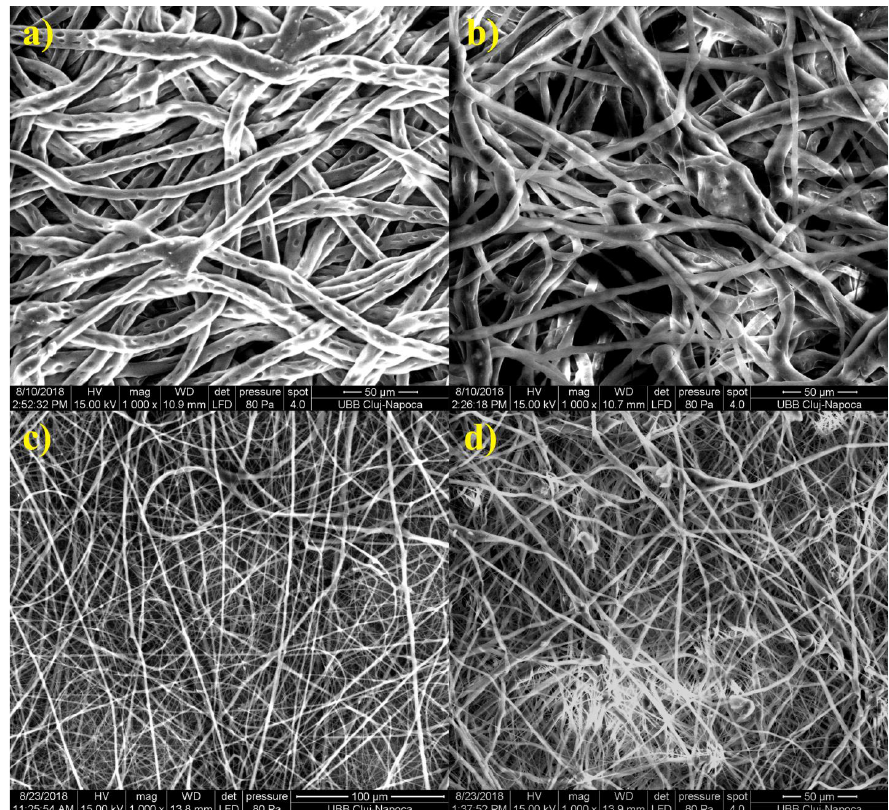
Figure 4. SEM micrographs of electrospun membranes: ( a ) PCL, ( b ) PCL-5% nHAP, ( c ) PCL-20% MET and ( d ) PCL-5% nHAP-20% MET.